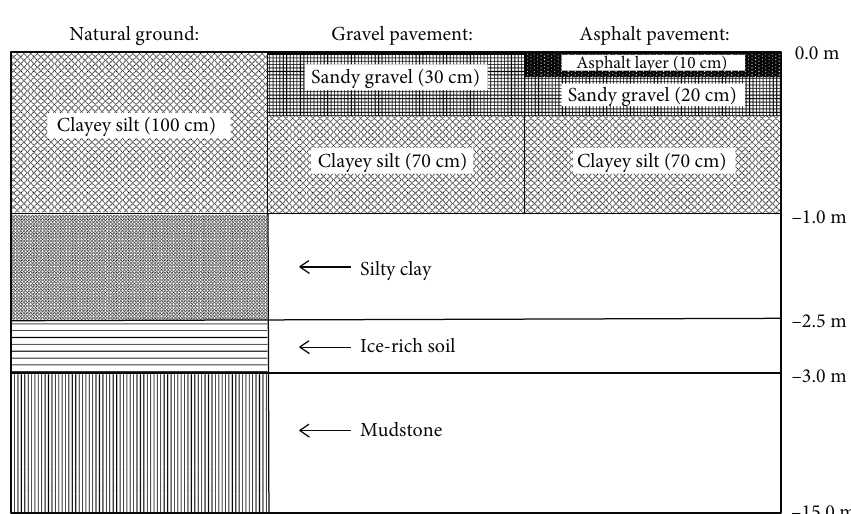
Figure 2: Vertical soil-layer distributions at the research